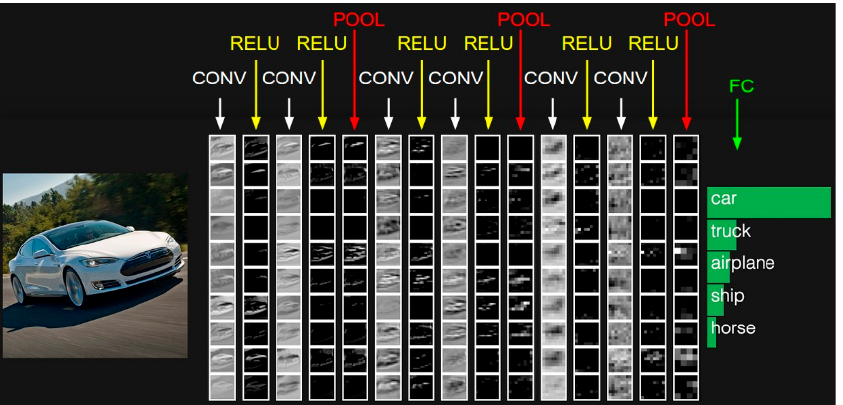
Figure 4. Convolutional neural network training process.